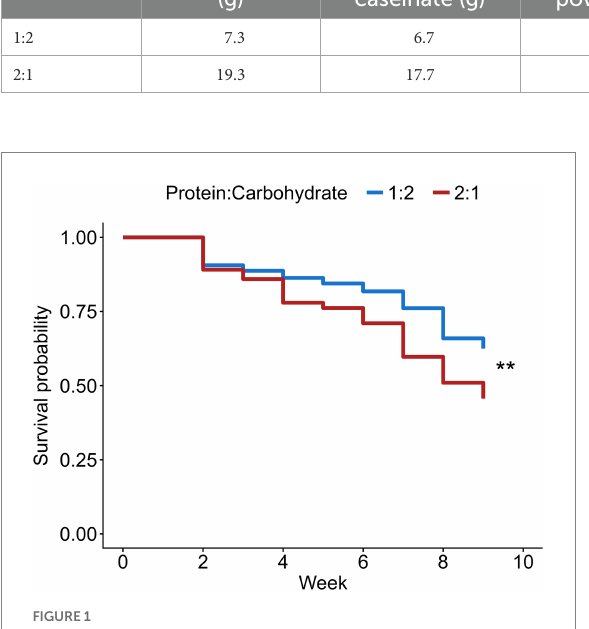
TABLE 1 Composition of the artificial diets with a 1:2 and 2:1 protein to carbohydrate ratio based on Dussutour and Simpson (2008). P:C Whey protein (g)